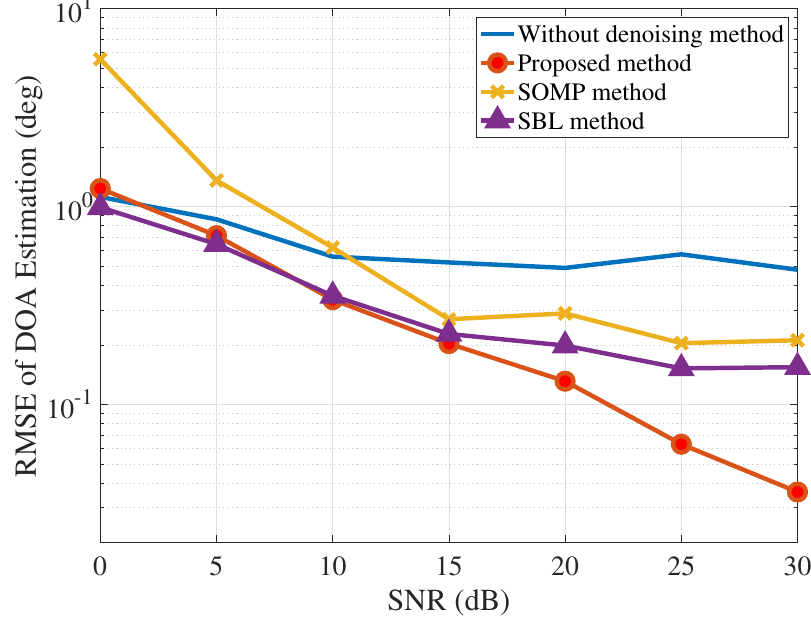
Figure 3. The DOA estimation with different